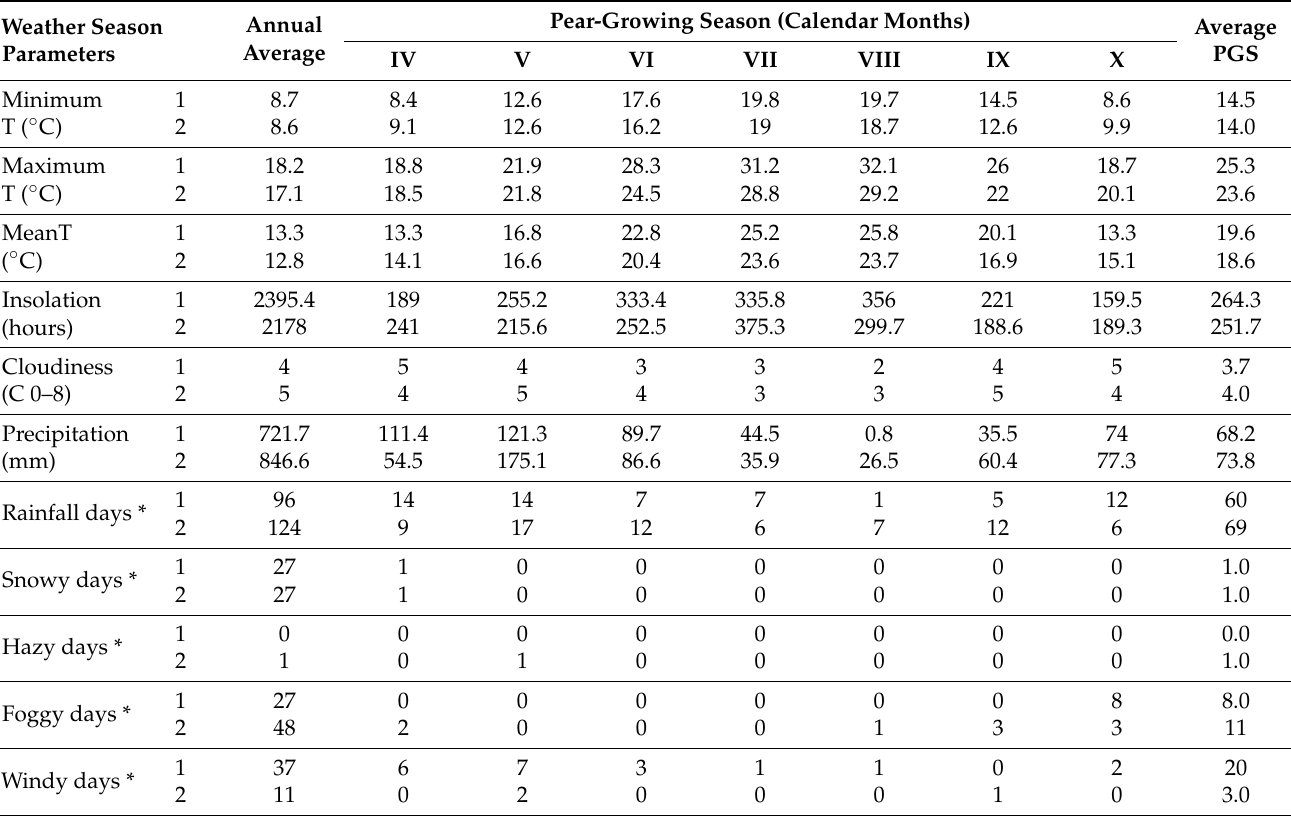
Table 1. Average values of weather parameters during the pear-growing season